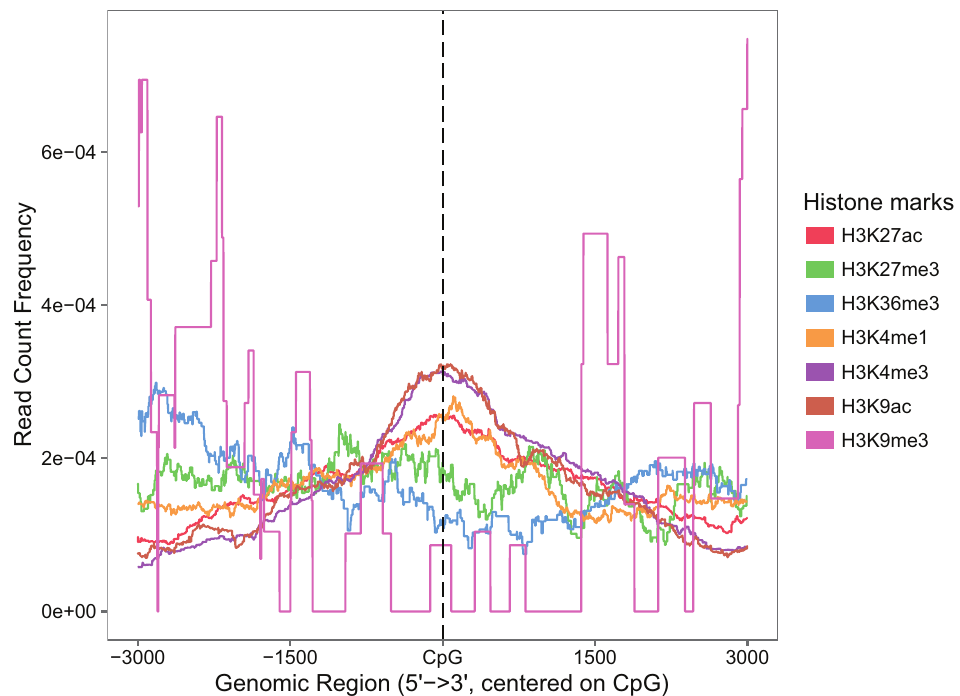
Figure 14. Average profiles for histone markers H3K27ac, H3K27me3, H3K36me3, H3K4me1, H3K4me3, H3K9ac, and H3K9me3. The figure indicates that the differentially methylated regions overlaps regions of enhancers, promoters and increased activation of genomic